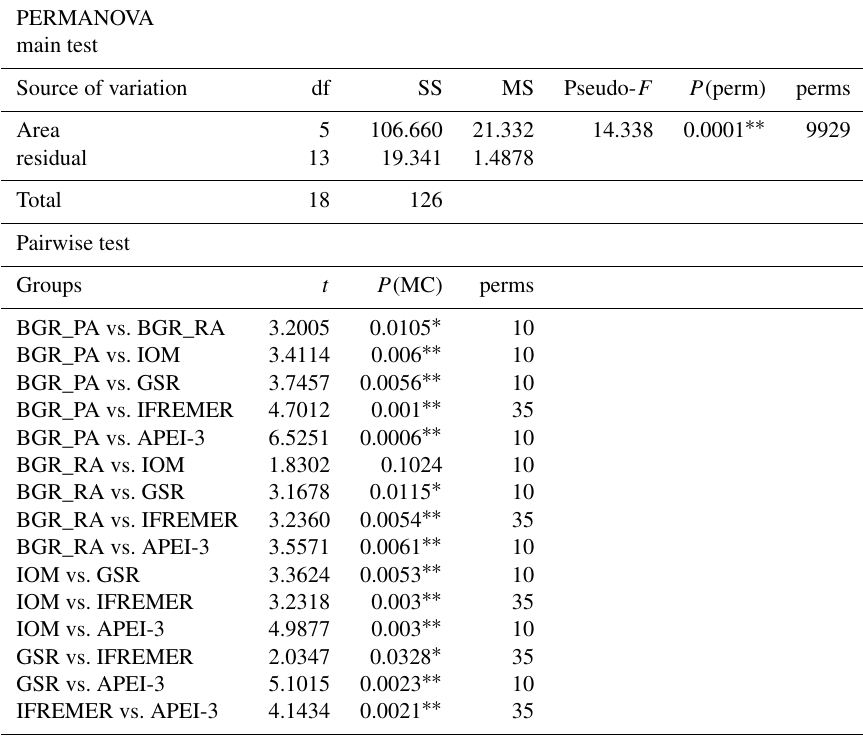
Table 2. PERMANOVA main and pairwise test results based on environmental variables. PERMANOVA design with one fixed factor (area; six levels). P values calculated by permutation (9999 permutations) at 5% significance level. df is degrees of freedom, SS is sum of squares, MS is mean squares, Pseudo- F and t are effect size, P (perm) and P (MC) are permutational or Monte Carlo P value, and perms is number of unique permutations. Asterisks indicate significant P values: ∗ < 0 . 05 and ∗∗ < 0 . 01.